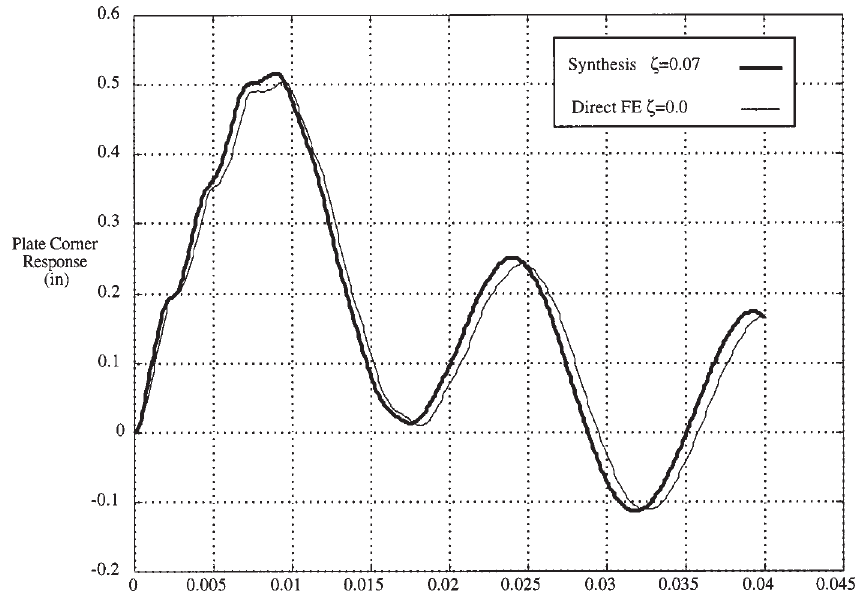
Fig. 8. Comparison of synthesis ( (cid:16) = 0 : 07) with Direct FE: Plate corner (at isolator) vertical response vs time.